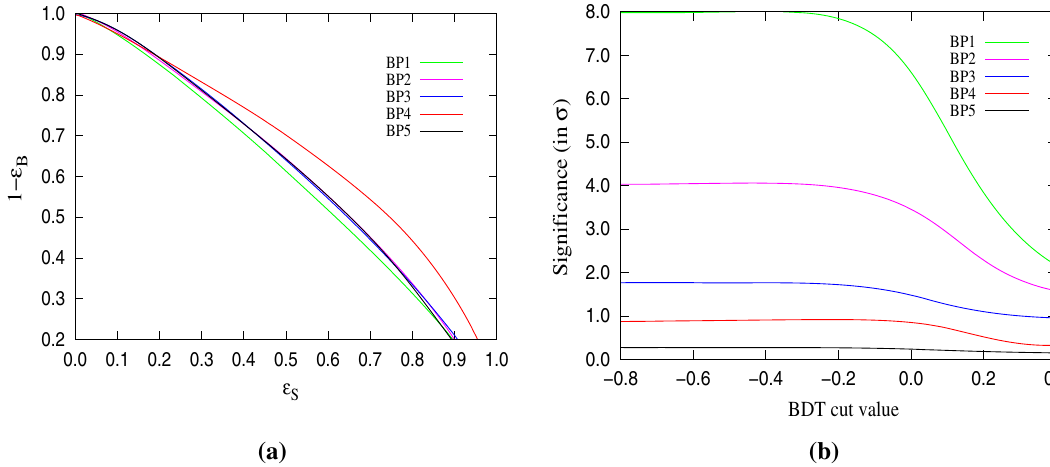
Fig. 9 a ROC curves for chosen benchmark points for 2 (cid:3) + E T / channel. b BDT-scores corresponding to BP1, BP2, BP3, BP4 and BP5 for 2 (cid:3) + E T /